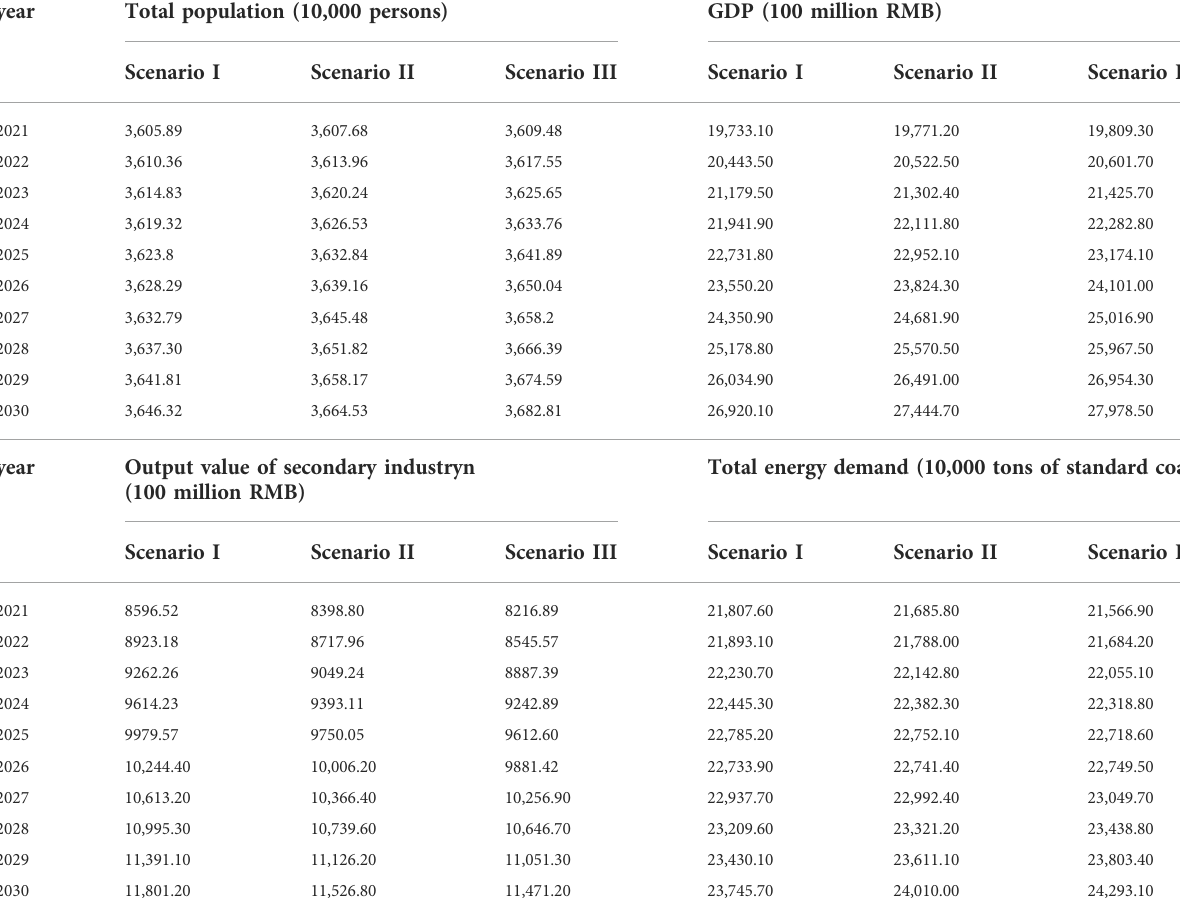
TABLE 5 Simulation results of population-economy-energy in Shanxi Province under different development